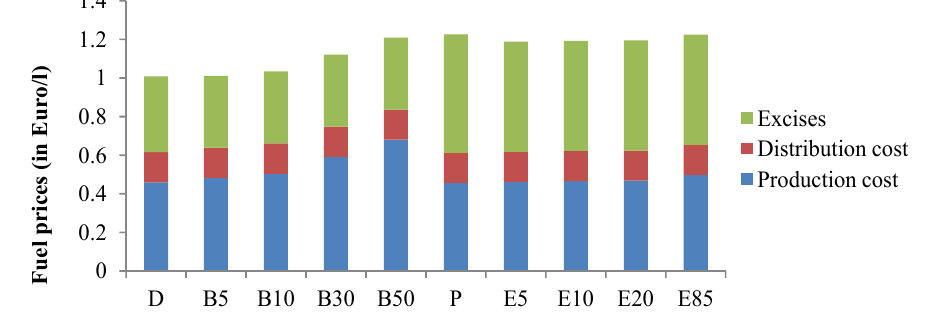
Figure 1. Breakdown of biofuel prices. (Source: Lievens and Jossart [31], Petrolfed